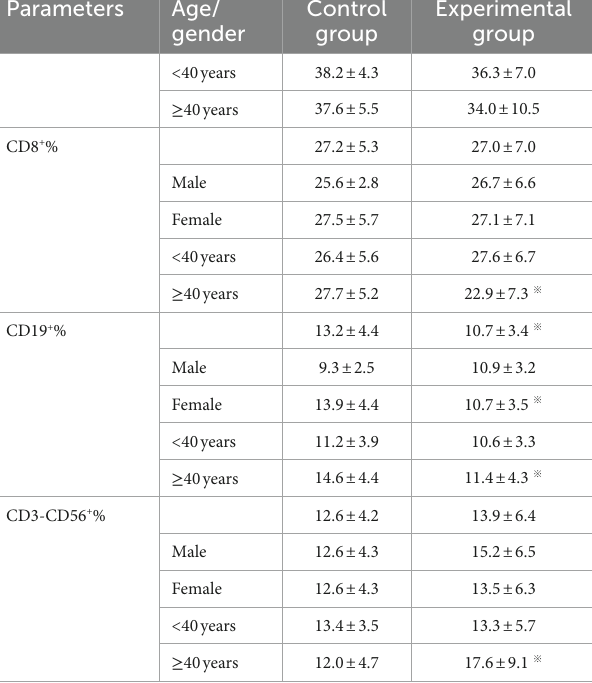
TABLE 2 The comparison between experimental group and control group (Mean ± SD, cells/ μ